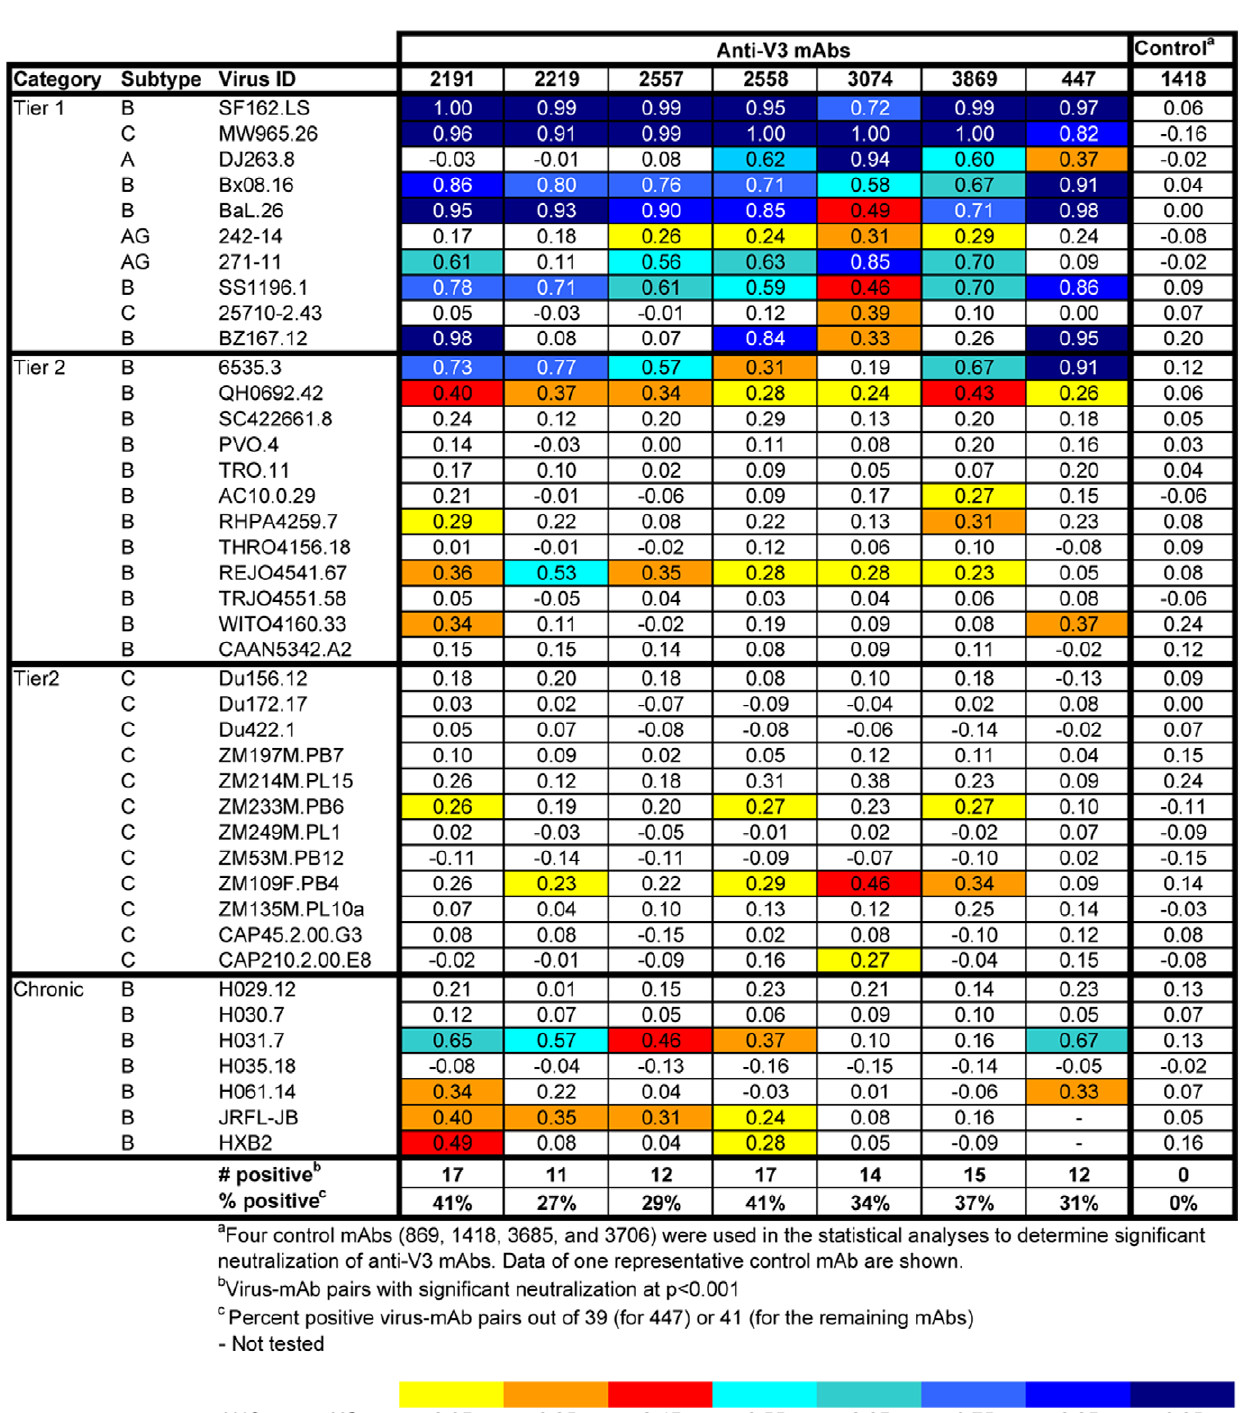
Figure 7. The AUC values of anti-V3 mAbs against 41 HIV-1 pseudoviruses tested using the TZM.bl target cell line. The AUC values were calculated from the titration curves as described in the Materials and Methods section. All mAb/psV pairs with statistically significant neutralization at p , 0.001 are color-coded according to the designated scale. The irrelevant anti-parvovirus mAb 1418 was used together with three other control mAbs (data not shown) as negative controls.